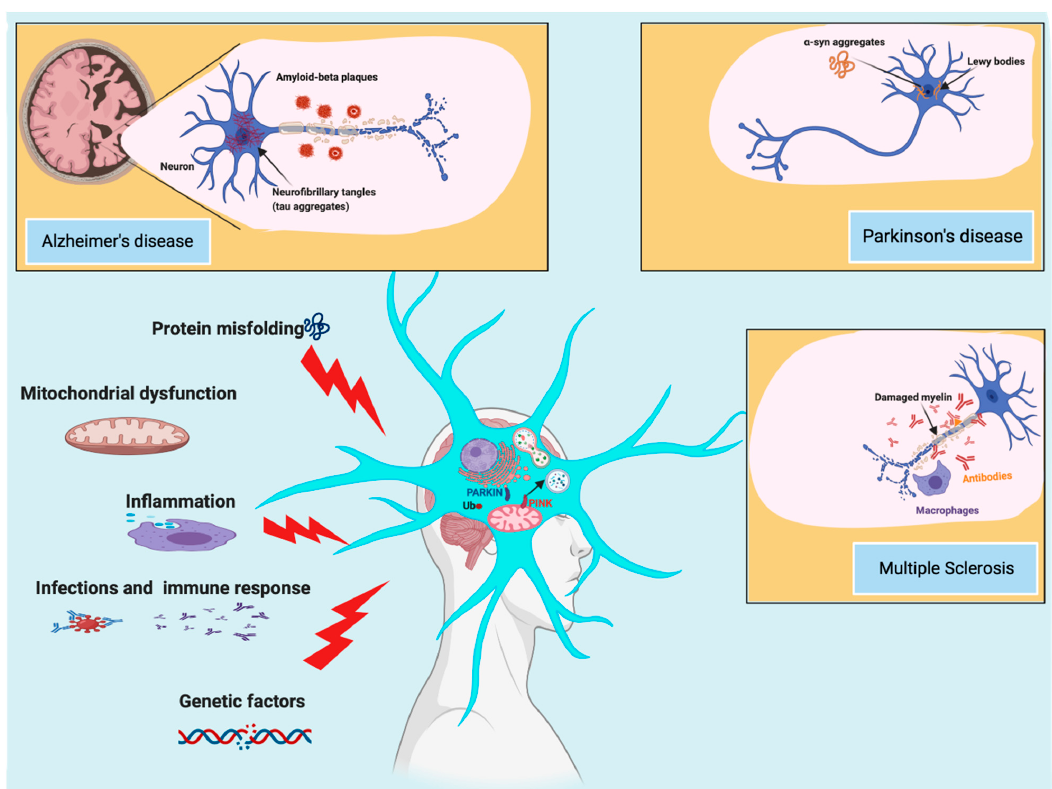
Figure 1. Causes and risk factors of Alzheimer’s disease (AD), Parkinson’s disease (PD), and multiple sclerosis (MS). AD and PD are the most common neurodegenerative diseases, characterized by an abnormal aggregation of protein inclusions in the brain. While in AD, the progressive loss of neurons is caused by an aberrant accumulation of beta-amyloid and tau protein, PD displays inclusions named Lewy bodies, where α -synuclein ( α -syn) is the major constituent. MS is the most frequent cause of disability among young adults after traumatic brain injury. The neurodegenerative condition of MS is not due to an excessive accumulation of misfolded protein but to adverse immune-mediated processes and chronic inflammation that provoke demyelinating and neurodegenerative processes during the entire life of the patient. Among the different molecular mechanisms and risk factors involved in these neurodegenerative conditions, it has been demonstrated that autophagy and mitophagy play an important role.